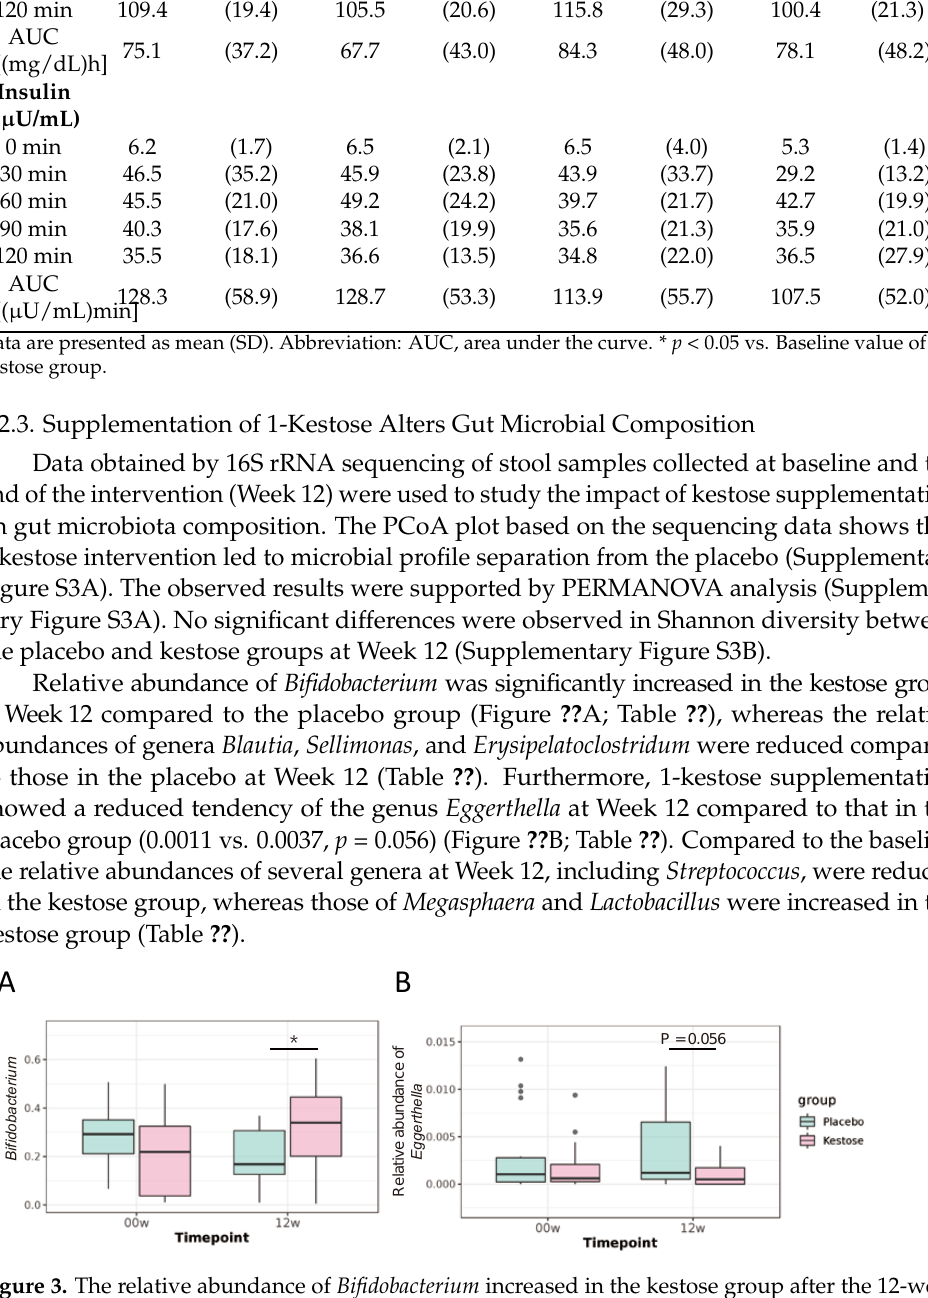
Table 2. Oral glucose tolerance tests at baseline and Week 12.